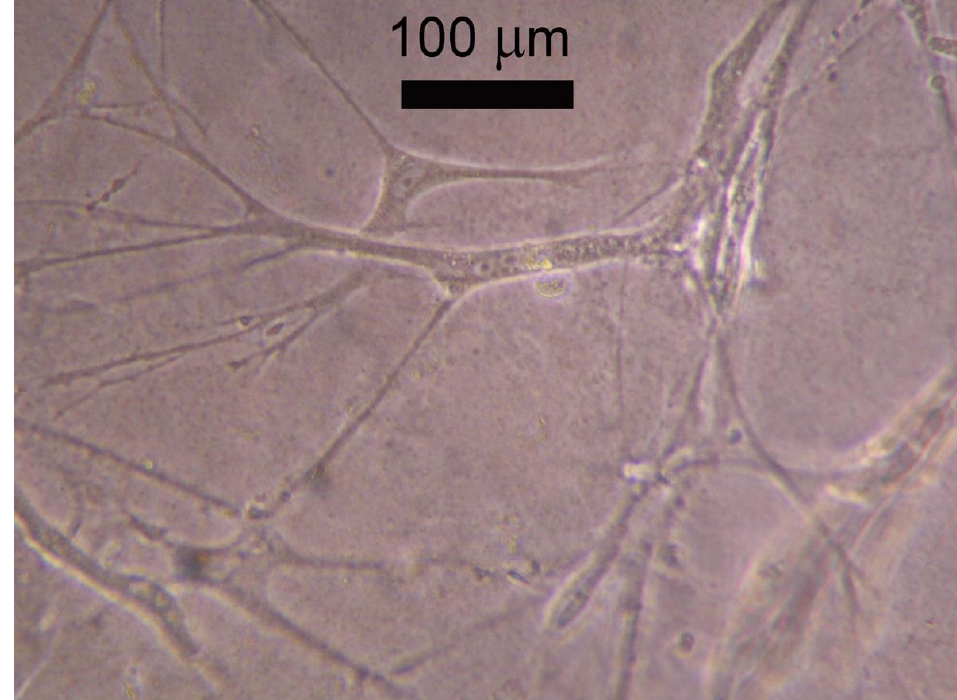
Figure 1. Human mesenchymal stem cells (hMSCs) on ultra-soft hydrogel: hMSCs could be cultured on ultra-soft hydrogel for 17 days and the extended morphology of healthy cells was observed.